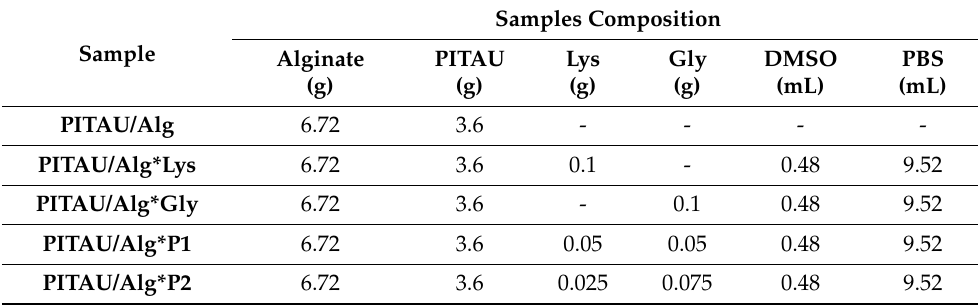
Table 1. The composition of the samples evaluated in the